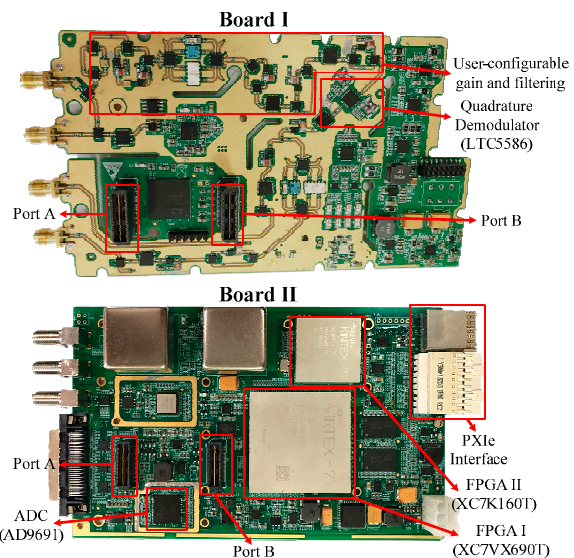
Figure 7. Receiver prototype.